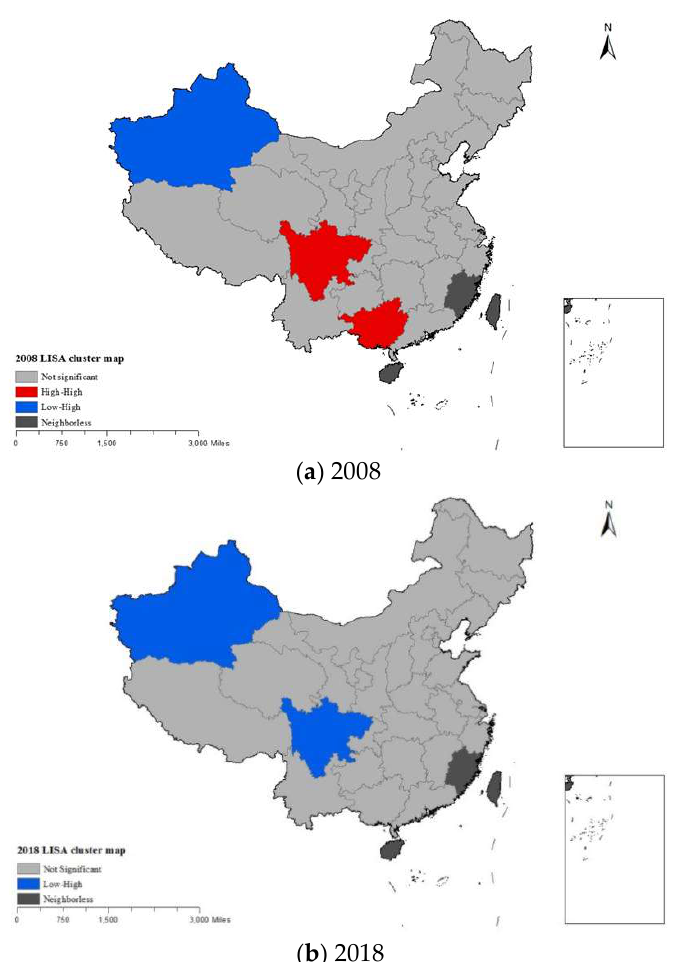
Figure 4. LISA cluster maps of corn production cost in various regions of China in 2008 and 2018.